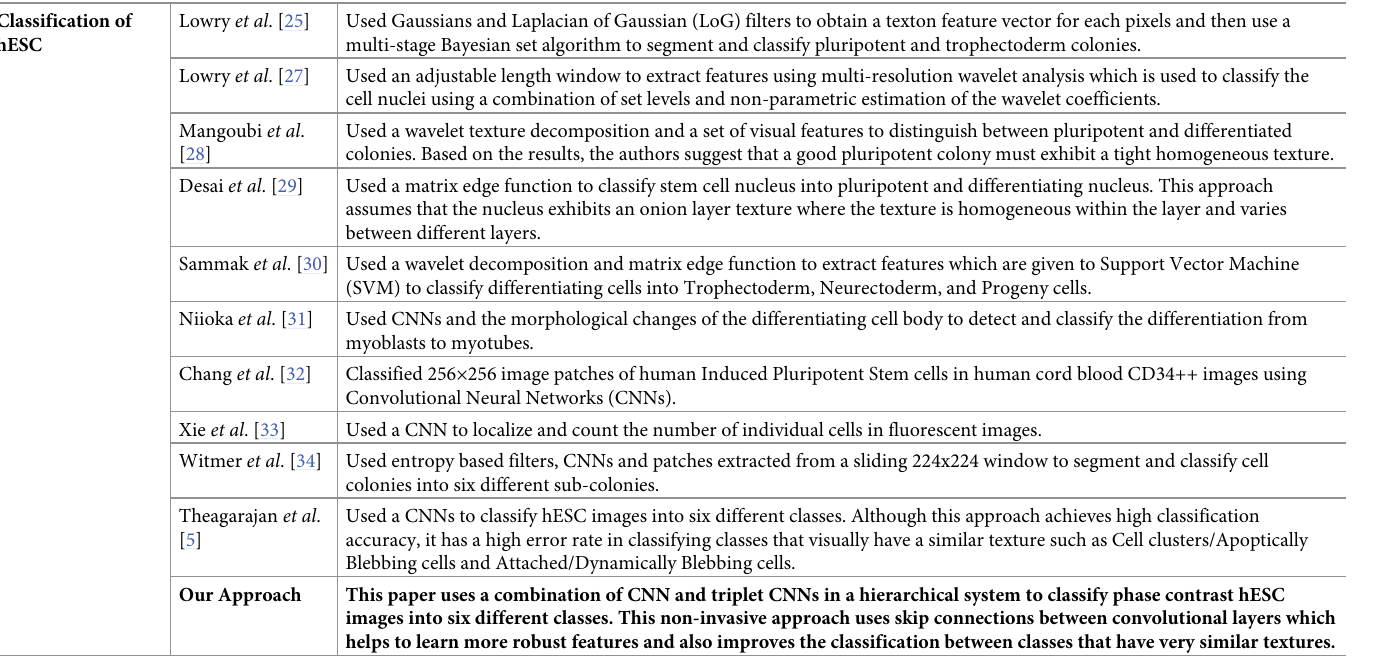
Table 2. Summary of the related work for classification of hESC and contributions of this